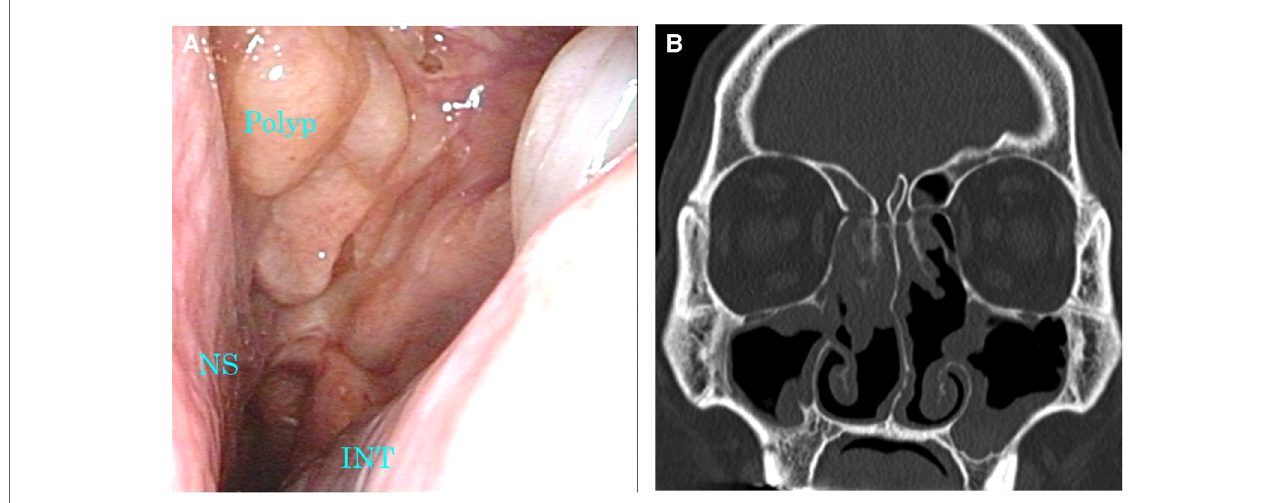
FIGURE 4 Images of nasal endoscopy and sinus CT 1 month after the diagnosis of SARS-CoV-2 infection. ( A ) A marked reduction of nasal polyps was con fi rmed. ( B ) Soft tissue density lesions in the sinuses were markedly reduced. CT, computed tomography; INT, inferior nasal turbinate; NS, nasal septum; SARS-CoV-2, severe acute respiratory syndrome coronavirus